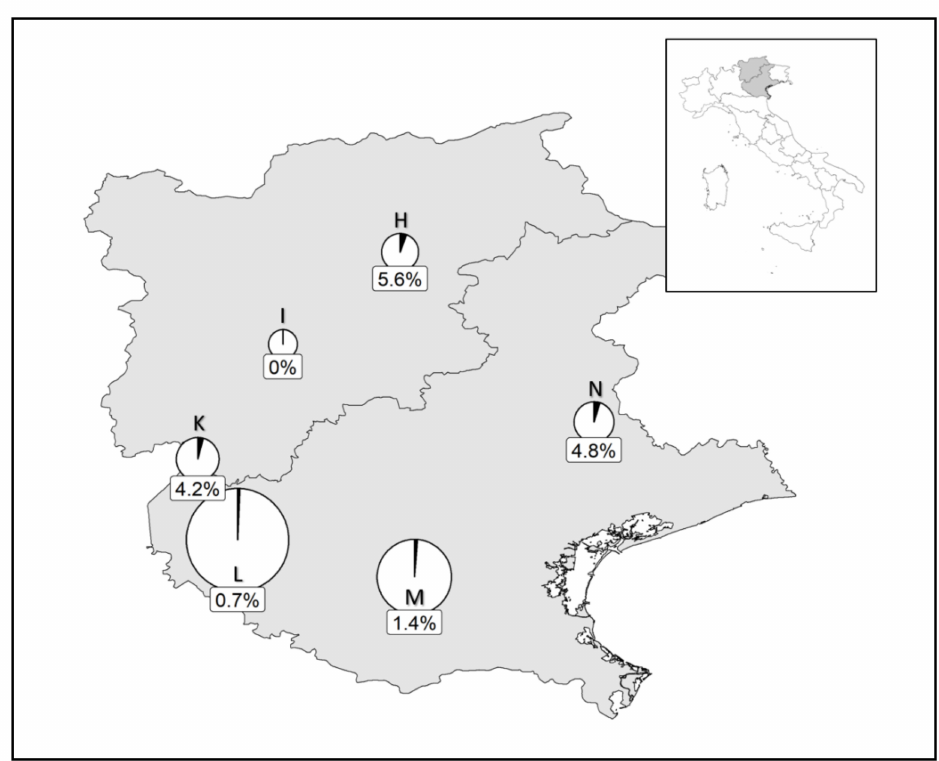
Figure3. Percentageof Philaenusspumarius parasitizedby Verralliaaucta insamplescollectedinnortheastern Italianregions(Trentino-AltoAdigeandVeneto)fromJulytoSeptember. Parasitizationrateswerecalculated by pooling data from the dissections and molecular analyses of samples collected in 2018 and 2019.